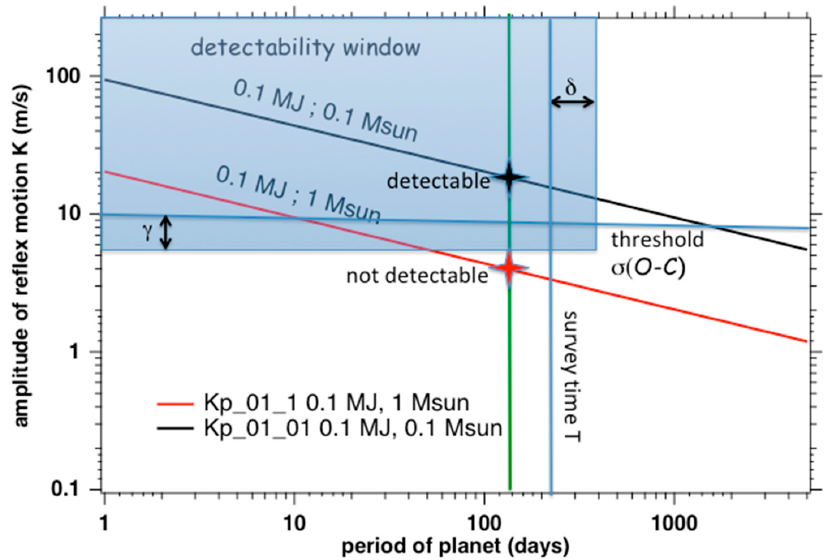
Figure A1. This is a sketch of the Detectability window, in a diagram of observables in one RV survey: the period and the amplitude K (m/s) of a sinusoidal variation of RV induced by a planet. The two solid lines represent the relation for a planet of 0.1 M J around a host star with 1 solar mass (red) and 0.1 solar mass M sun (black). The same planet will be detected around a host star with mass 0.1 M sun and not detected around a host star with mass 1 M sun . The rectangular blue-shaded area represents the area of the detectability window; γ and δ are two multiplicative factors affecting the boundaries of the detectability window that can be adjusted simultaneously to all surveys, for a more homogeneous treatment (see text).